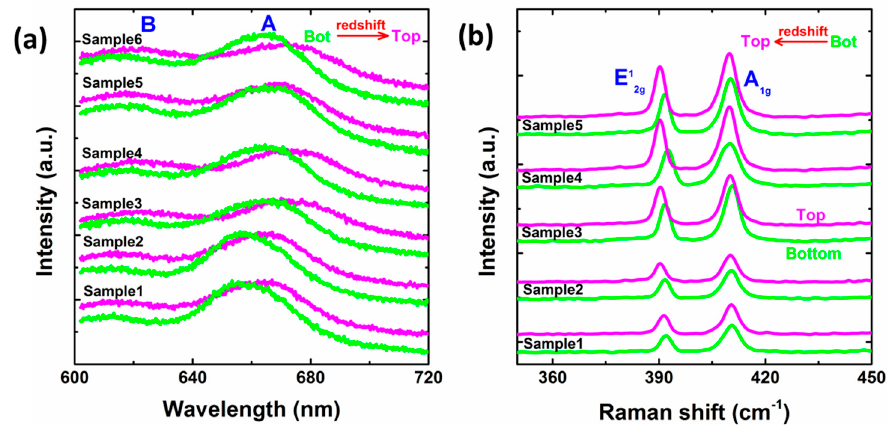
Figure 2. Photoluminescence and Raman spectra comparison between bottom (green) and top (magenta) layers. Bot and Top refer to bottom and top region, respectively. ( a ) PL spectra comparison. For clarity, spectra of one same tBLS sample are shifted vertically in small gap while spectra of different tBLS samples in large gap. Peak A and B are labeled. ( b ) Raman spectra comparison. Mode E 1 2g and A 1g are labeled.